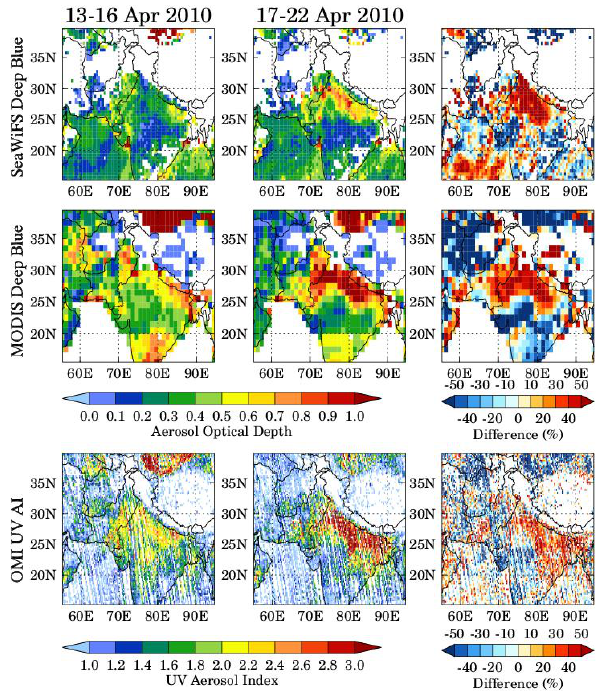
Fig. 9. Spatial distributions of aerosol optical depth at 550nm from SeaWiFS at 0.5 ◦ × 0.5 ◦ (top panels) and MODIS aboard Aqua at 1 ◦ × 1 ◦ (middle panels), and OMI UV aerosol index at 0.25 ◦ × 0.25 ◦ (bottom panels) during 13–16 April 2010 (low dust period) and 17–22 April 2010 (high dust period). The percentage changes in aerosol properties during high dust period relative to low dust periods are shown in rightmost middle and bottom panels.